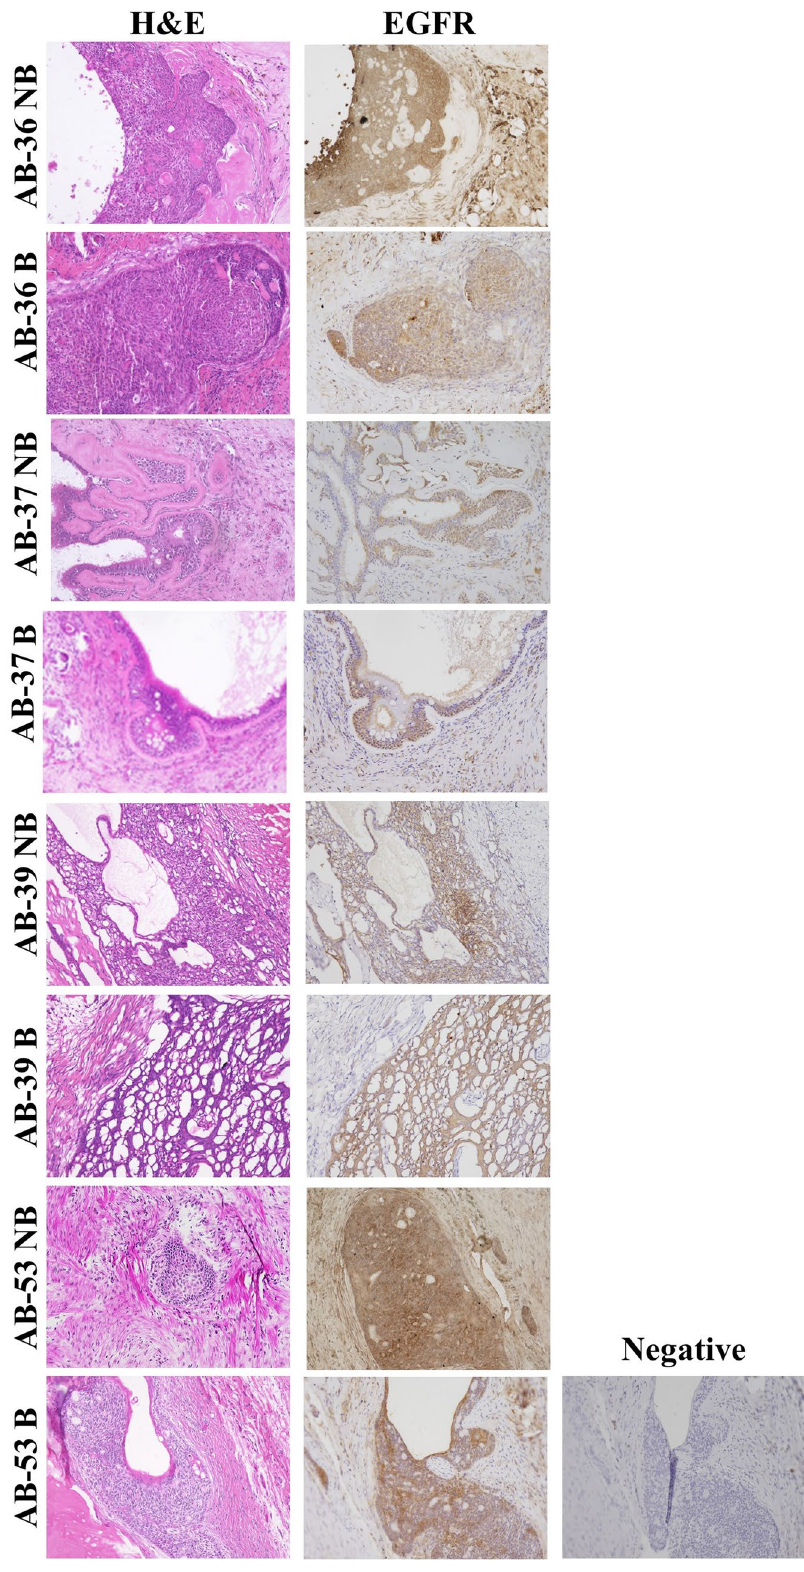
Figure 4. Ameloblastoma tumor tissue was confirmed in xenografts after resection by pathologic assessment (NB = non-blocking group; B = blocking group). Resected tumors, 7–9 weeks post implantation, were processed, embedded in paraffin and stained with hematoxylin and eosin (H&E, first column) or anti-EGFR for immunohistochemistry (second column) (20×). Negative controls (third column) show staining without primary